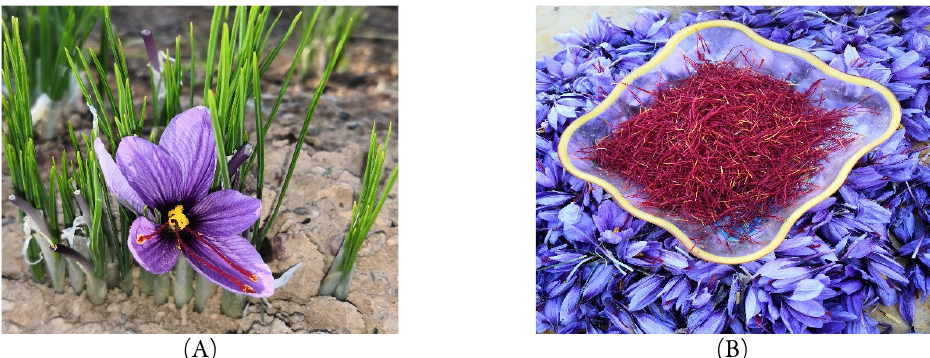
Figure 1. Crocus sativus plant morphology: (A) saffron plant; (B) Saffron Flowers and